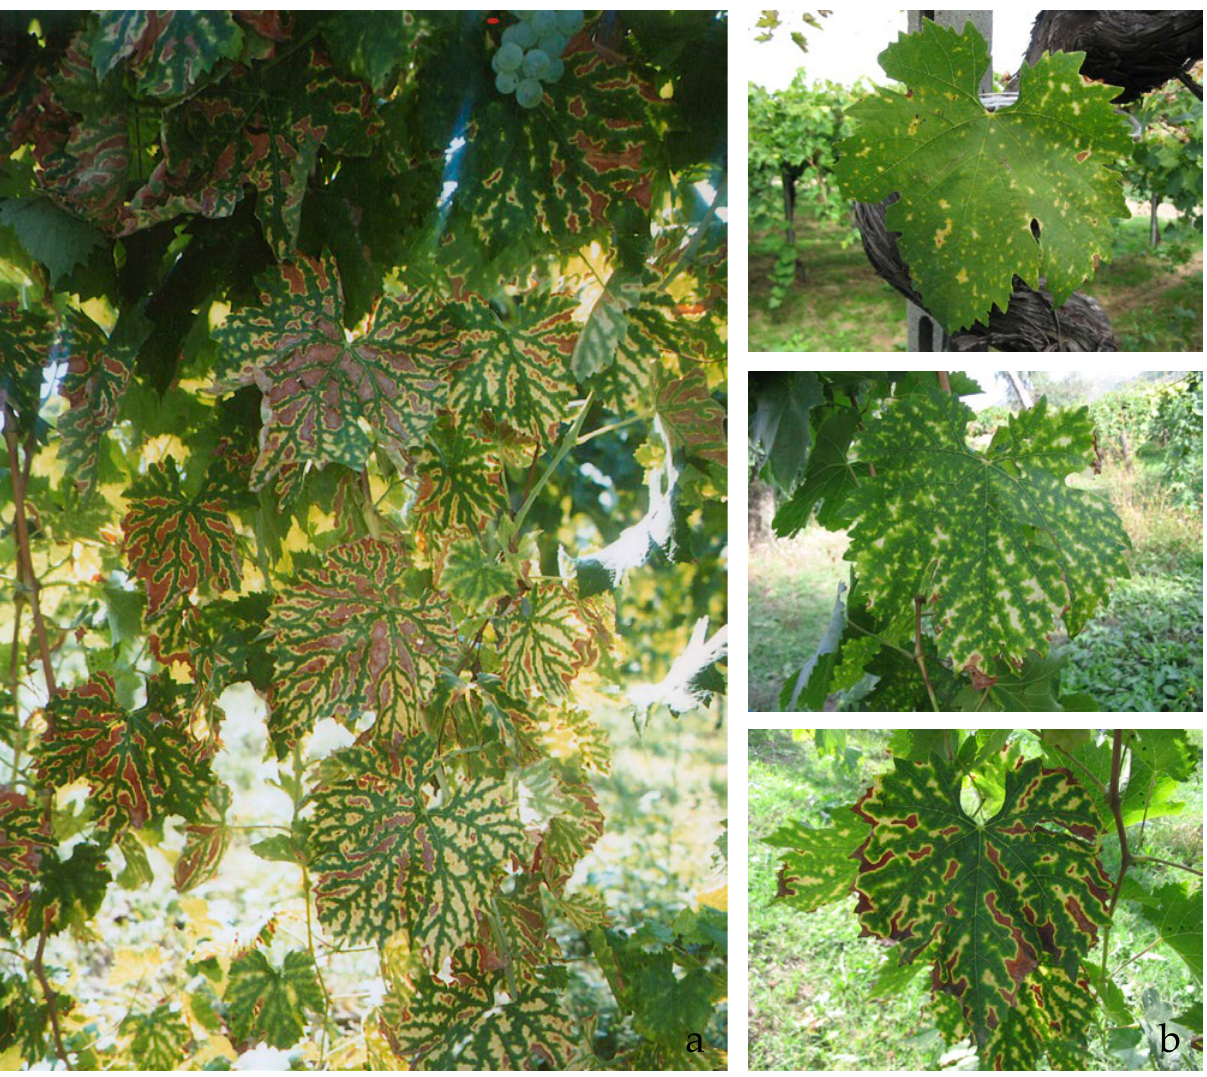
a Figure 1. Grapevine leaf stripe disease foliar symptoms in the Trebbiano d’Abruzzo vineyard (a) Foliar symptoms evolve from yellow spots in the interveinal area to necrotic areas surrounded, in this cultivar, by a yellow border (b).